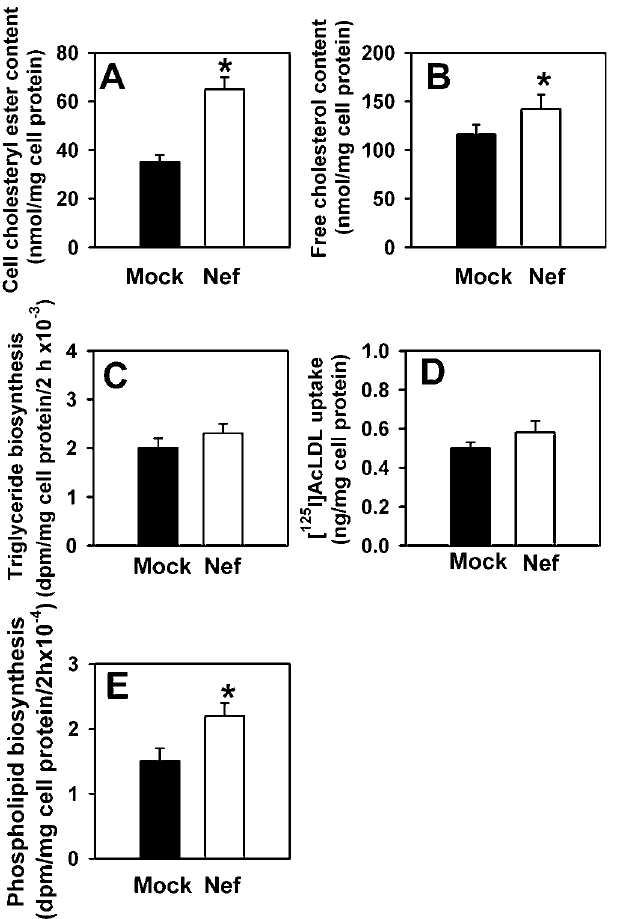
Figure 7. Analysis of Lipids in RAW 264.7 Macrophages Transfected with Nef (A) Cholesteryl ester content after 24 h incubation with AcLDL (50 l g/ml) determined by enzymatic assay; an asterisk (*) indicates p , 0.01. (B) Free cholesterol content after 24 h incubation with AcLDL (50 l g/ml) determined by enzymatic assay; an asterisk (*) indicates p , 0.05. (C) Triglyceride biosynthesis after 24 h incubation with AcLDL (50 l g/ml) measured as incorporation of [ 14 C]oleic acid into triglycerides as DOI: 10.1371/journal.pbio.0040365.g007